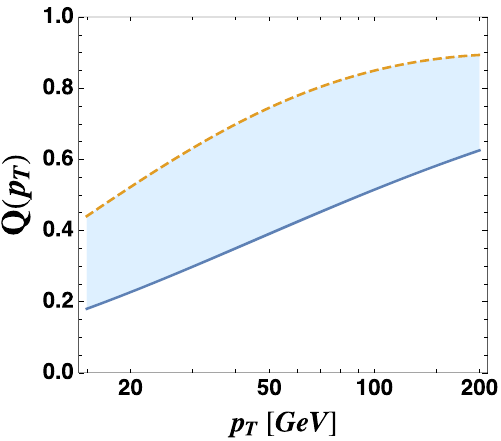
Fig. 2 The quenching factor for massless quark Q ( p T | m = 0 ) that enters the calculation of the collimator function. The full (lower) line corresponds to the quenching factor with the leading BDMPS-Z soft- gluon spectrum, cf. first term in (22), while the dashed (upper) line contains sub-leading corrections, cf. (36). The shaded area between the curves corresponds to the uncertainty in modeling radiative energy